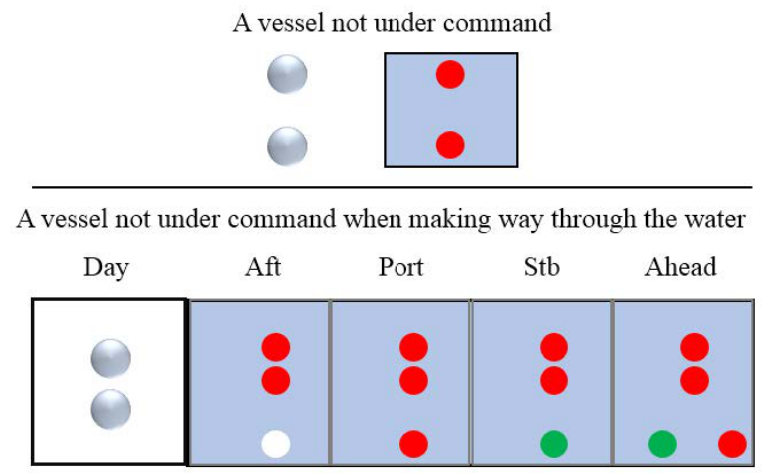
Figure 1. Vessel not under command navigational lights 2 .